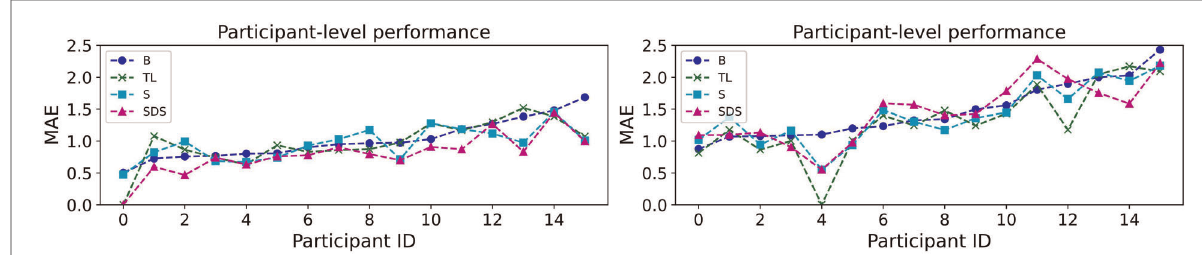
FIGURE 5 Individual-based MAE performance for PHQ-2 prediction (left) and forecasting (right) using the (B)aseline model as well as the three personalisation methods: (T)ransfer (L)earning, (S)ubgroup models, and (S)ubject-(D)ependent (S)tandardisation. The MAE values are calculated using the samples of each participant of the study. The participants are sorted from best to worst performance of the baseline model.